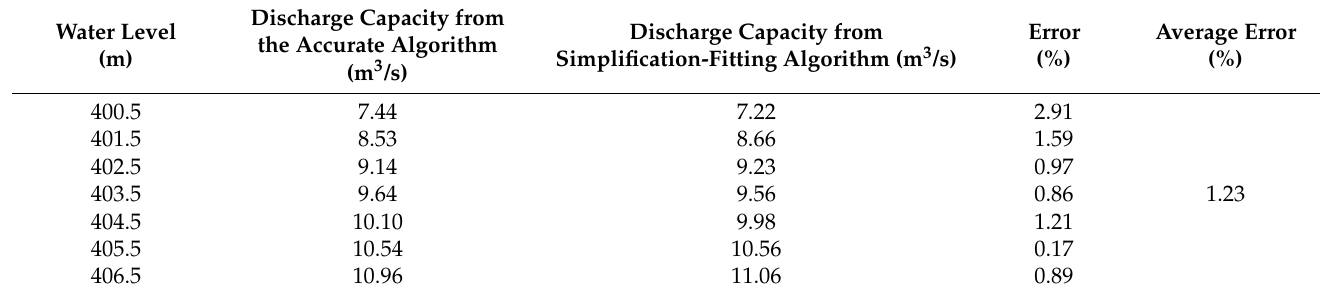
Table 4. Statistical table on errors between the simplified and accurate algorithms in the pressure flow stage.